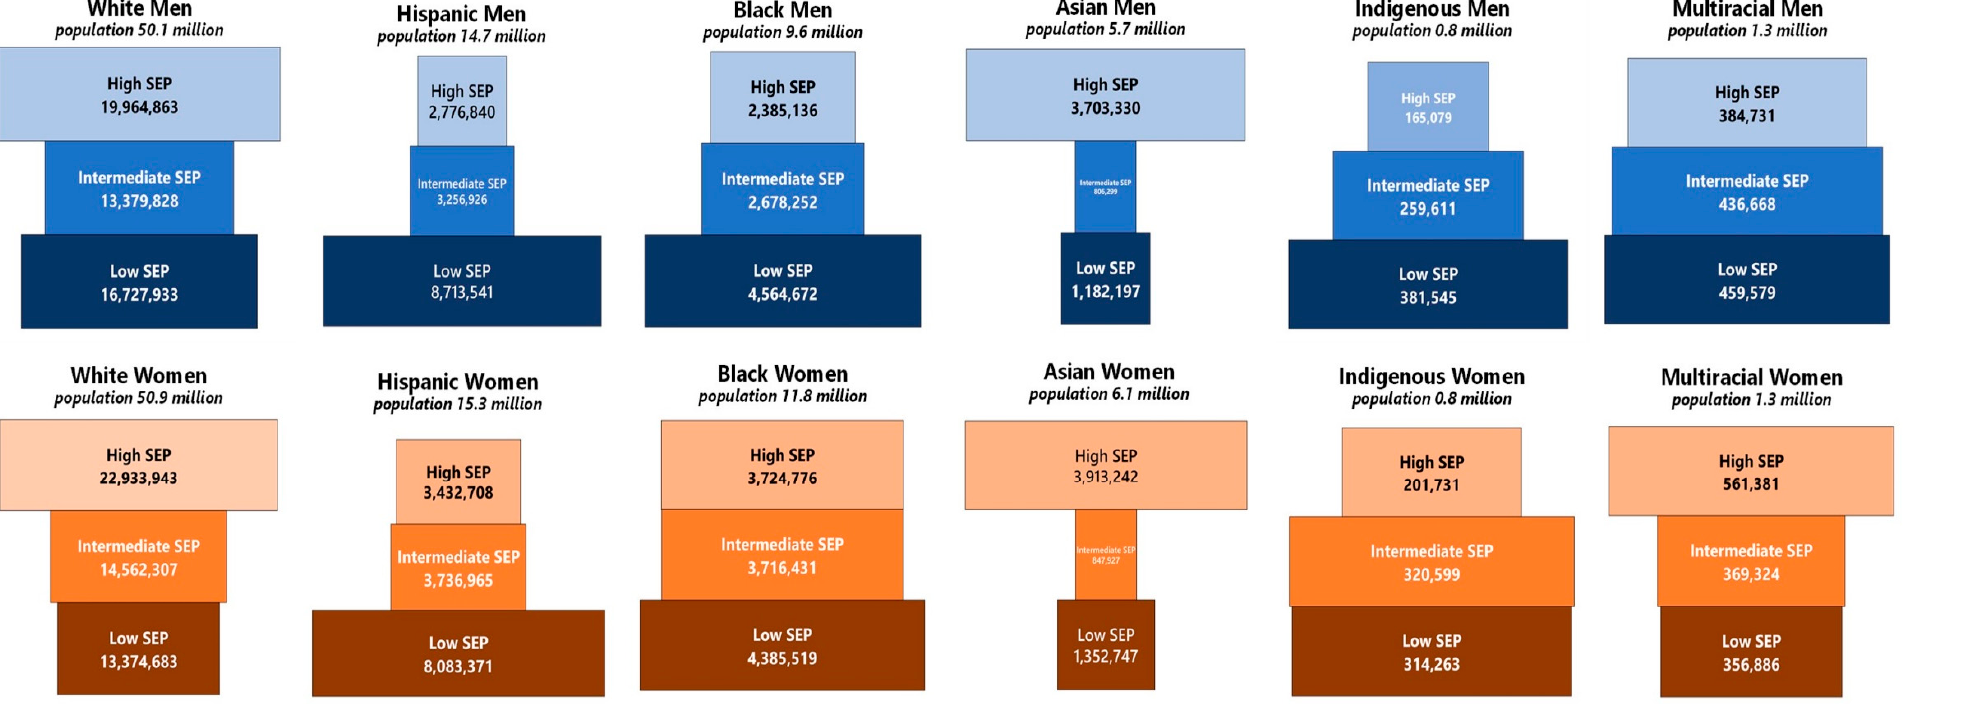
Figure 2. Socioeconomic Position (SEP) Population Pyramids * among Adults 25–64 Years Old ( n = 168.4 million), United States 2020. Note : * The width of each bar is proportional to the size of the social class stratum within each race/ethnicity-gender group. Indigenous includes American Indians, Alaska Natives, Native Hawaiians, and other Pacific Islanders.